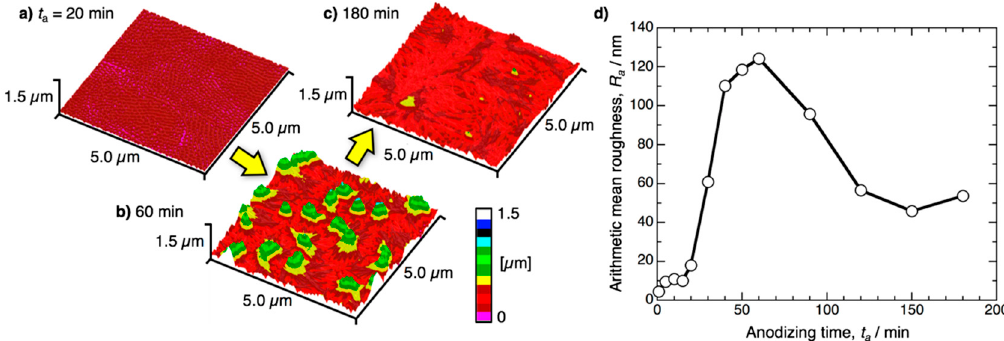
Figure 5. Three-dimensional AFM images of the pyramidal bundle structure consisting of anodic alumina nanofibers formed at 283 K and 80 V . t a = ( a ) 20 min, ( b ) 60 min, ( c ) 180 min. ( d ) Change in